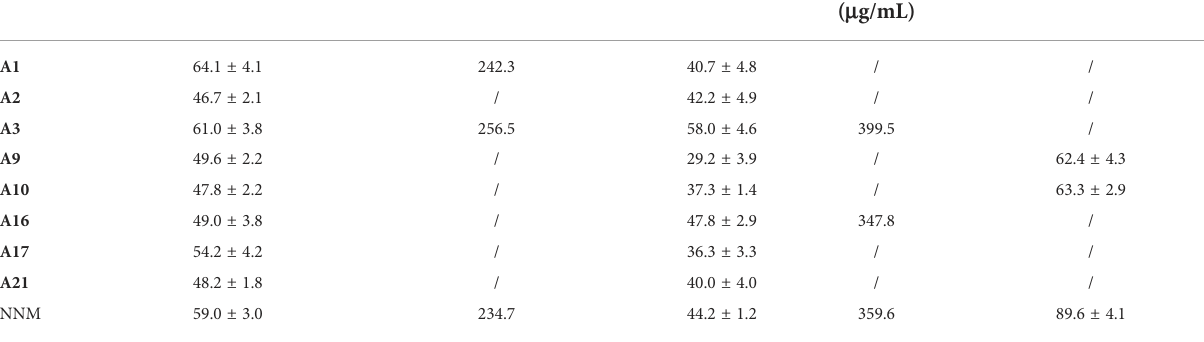
TABLE 3 Activity of compounds A1-A27 on